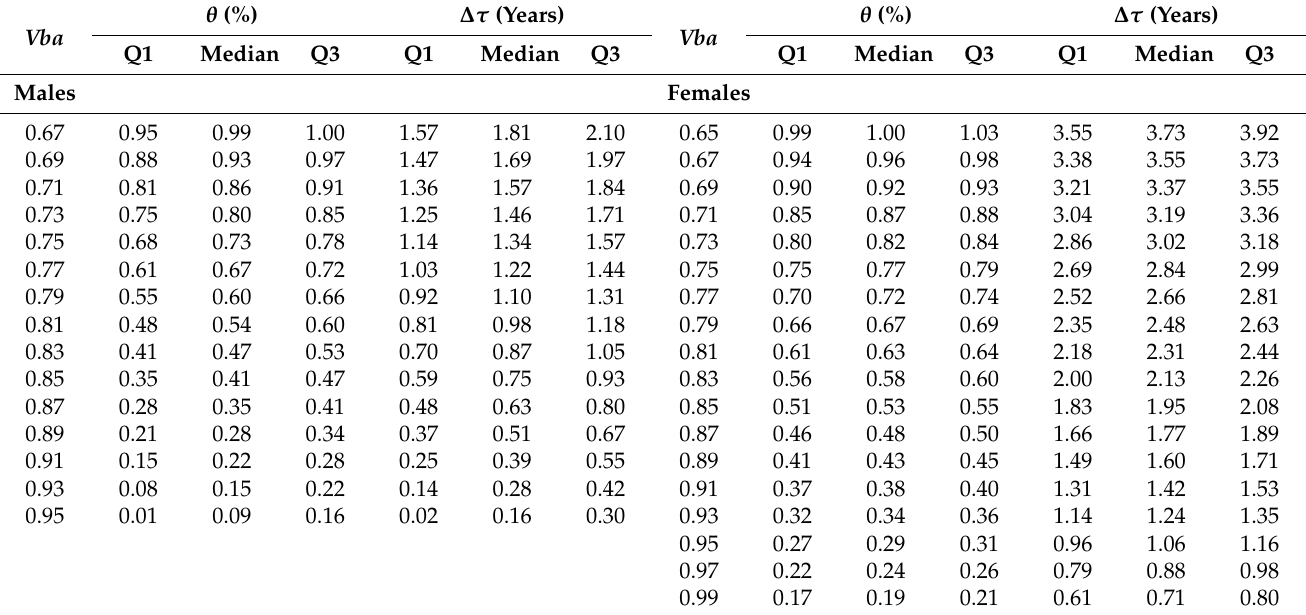
Table 2. Median, first, and third quartile of the distribution of the residual proportion of the matura- tion, θ (%), and the time elapsed to the end of the pubertal spurt, ∆ τ (years), for the given ratio of projections of the anterior and posterior heights of the C4 vertebral body ( Vba ) in males and females.